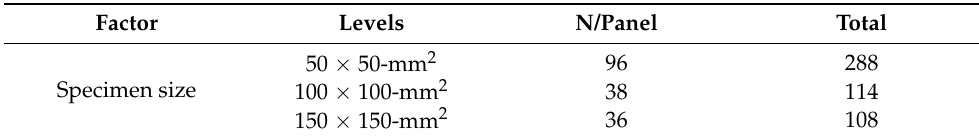
Table 1. Experiment design for density